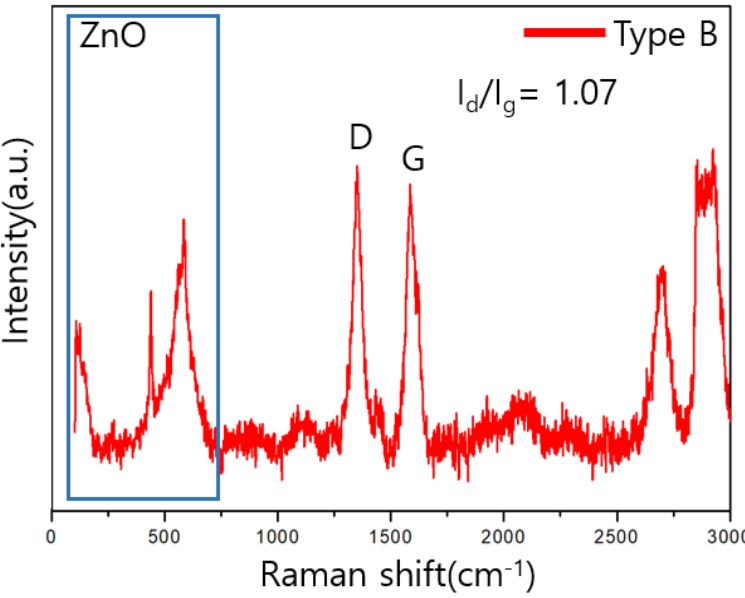
Figure 8. Raman analysis results for type B samples.